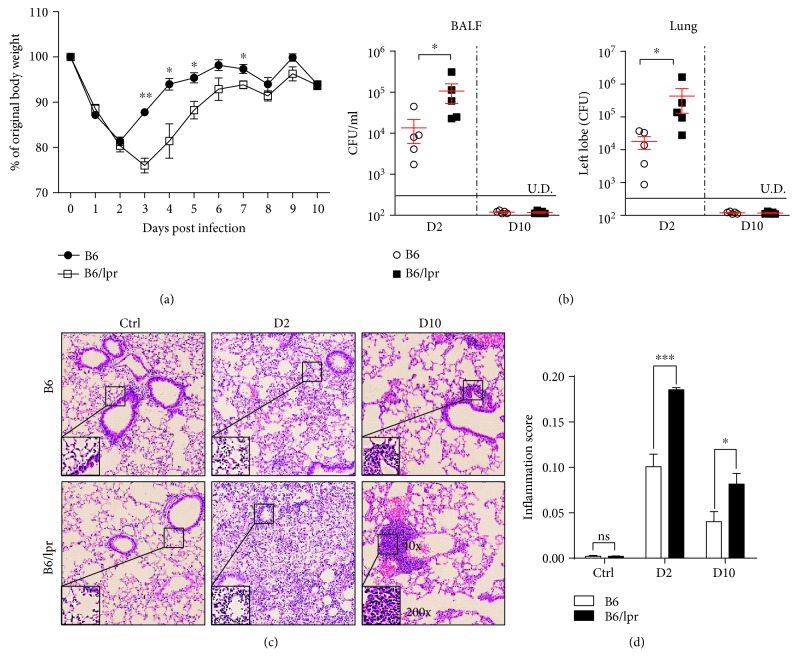
Lupus-prone mice exhibited delayed bacterial clearance and severer lung injury after infection. (a) B6 and B6/lpr mice were infected with 1 × 108 CFUH. influenzae (strain 86-028NP) intranasally. Their bodyweight changes were monitored until fully recovered. B6 mice: circle; B6/lpr mice: square. Mice were infected as described before and sacrificed on Days 2 (D2) and 10 (D10) after infection. (b) Bacteria in the BALF and lungs were recovered and determined. Lung pathology was examined by H&E staining. (c) H&E staining of representative animals. Original magnification: 40x; inlets: 200x. (d) Histopathological mean inflammation scores of lungs. Data were expressed as means ± SEM. n = 3‐5 mice for each treatment group. ∗p < 0.05, ∗∗p < 0.01, and ∗∗∗p < 0.001. ns: no significant difference; U.D.: under the limit of detection. This experiment is representative of three individual experiments.